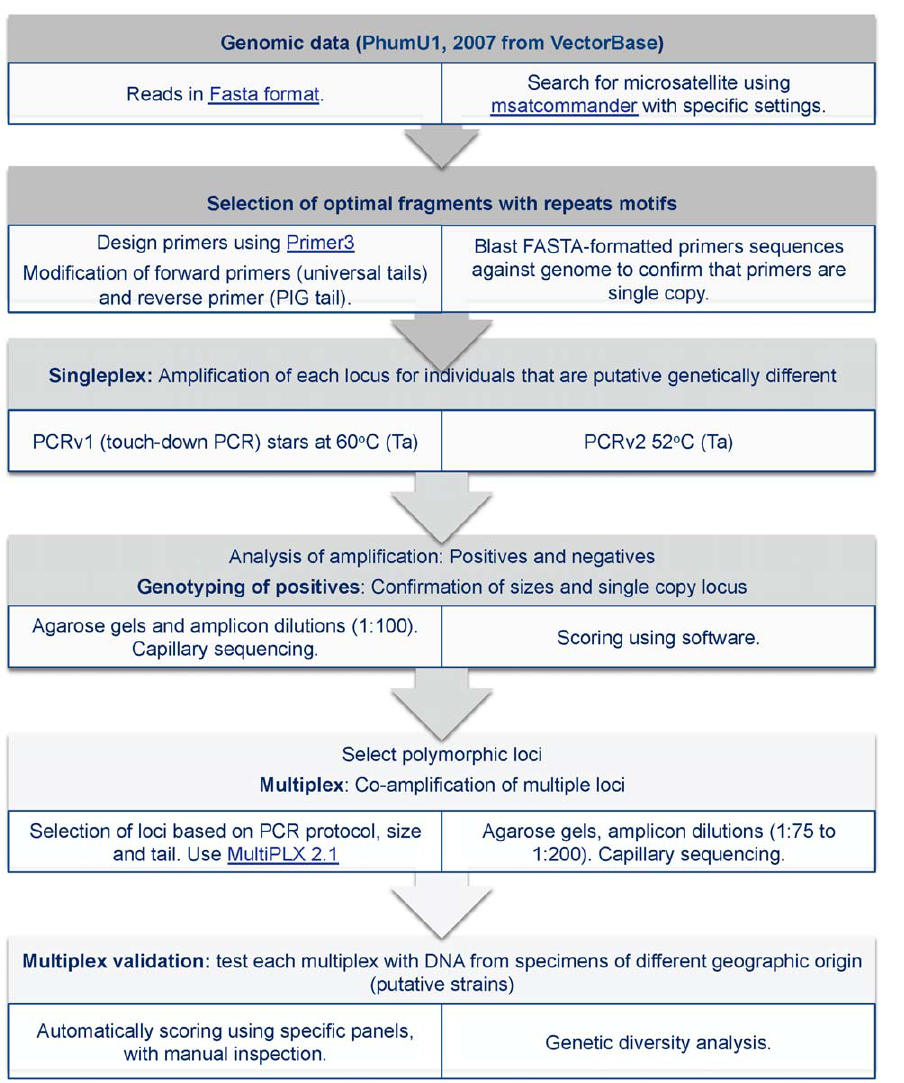
Figure 2. Analytical pipeline used to develop microsatellite loci from genomic data including the development of multiplexes using multiple fluorescently labeled universal primers. Ta: Annealing temperature. (see Methods S1 for details and references).